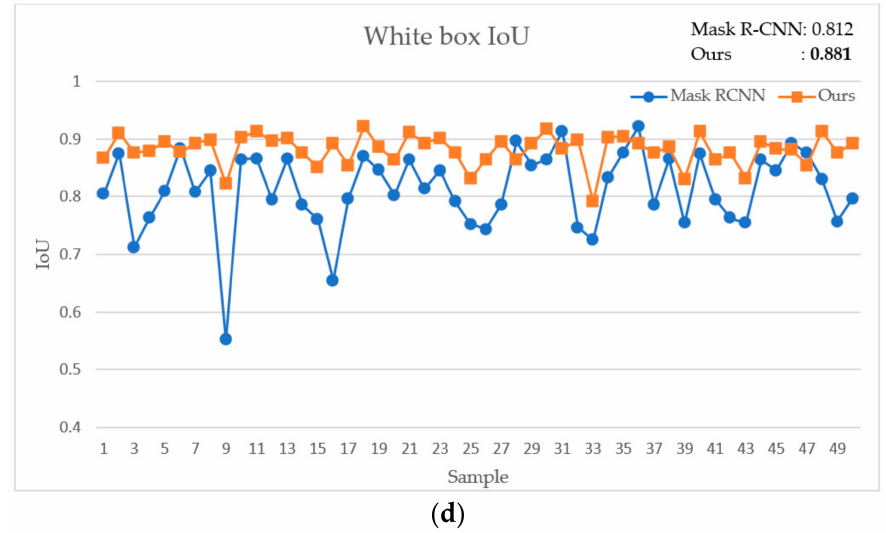
Figure 8. The comparison between Mask R-CNN and our proposed method through four objects. ( a ) Cup IoU, ( b ) Blue box IoU, ( c ) Cylinder IoU, ( d ) White box